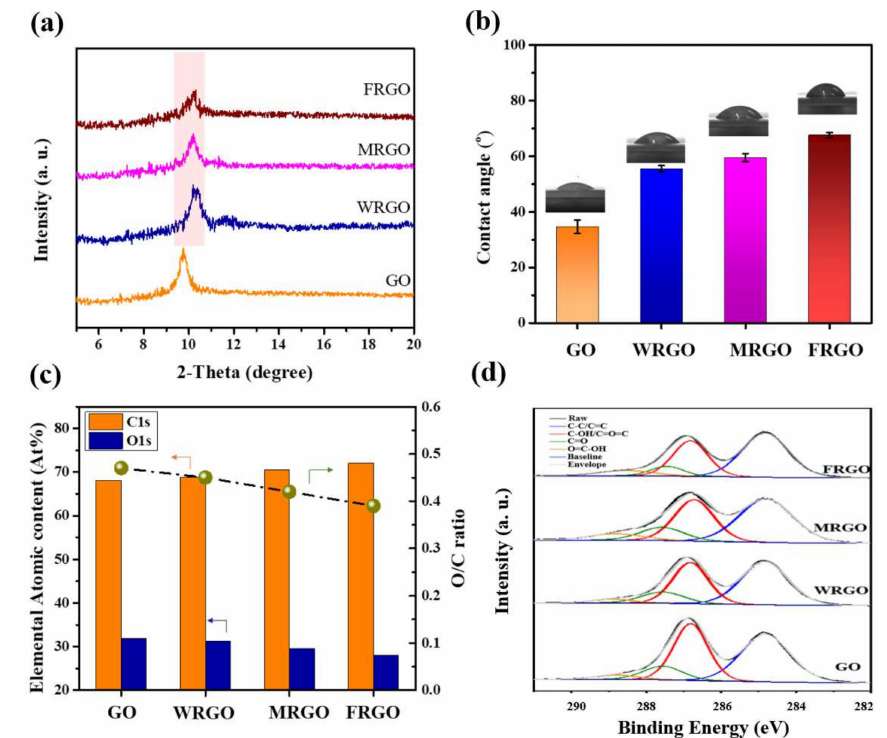
Figure 2. The characteristics of the GO membrane, WRGO membrane, MRGO membrane, and FRGO membrane. ( a ) XRD patterns in the dry state, ( b ) water contact angles, ( c ) elemental atomic contents, and ( d ) XPS spectra of GO membrane, WRGO membrane, MRGO membrane, and FRGO membrane. Detailed spectral fitting and interpretation of the membrane showing raw data (black lines), Envelope lines (grey lines), C-C/C=C peaks (blue lines, 284.8 eV), C-OH/C-O-C peaks (red lines, 286.7 eV), C=O peaks (green lines, 287.6 eV), and O=C-OH peaks (orange lines, 288.8